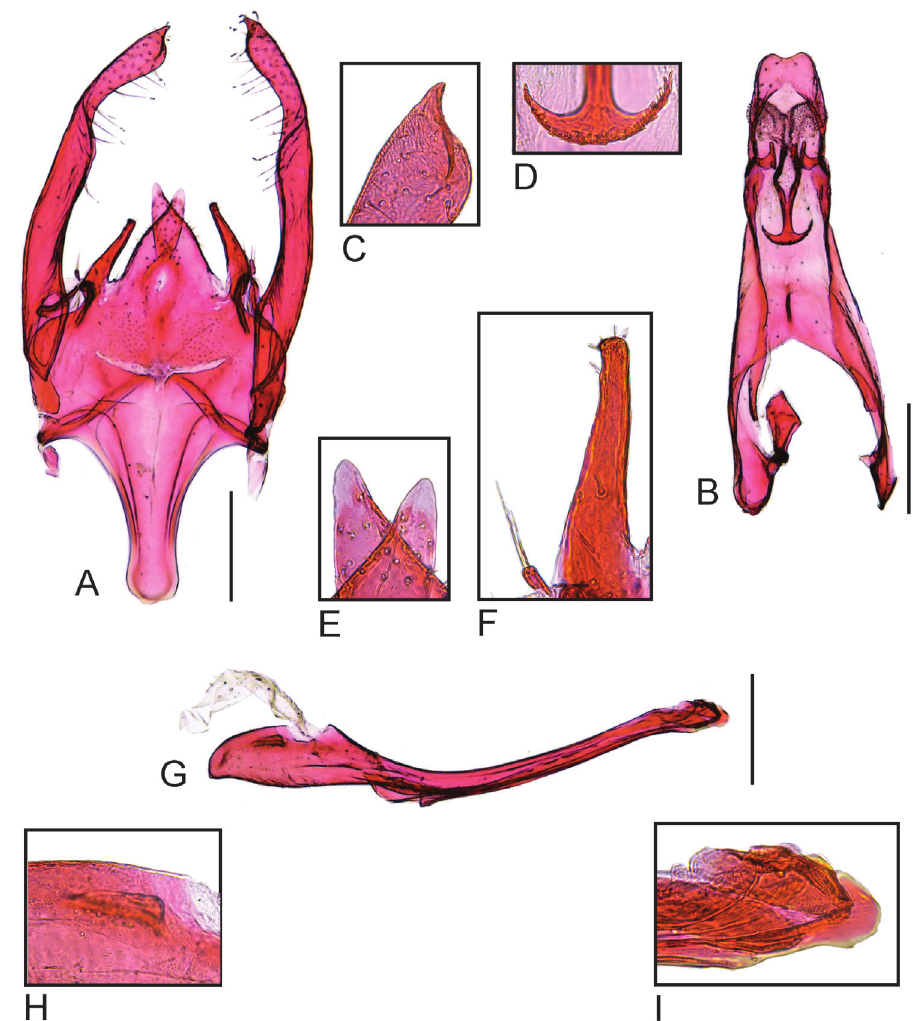
Figure 4. Male genitalia of Scrobipalpulopsis aguilaensis sp. nov. A valvae, vinculum and saccus, ventral B tegumen, uncus and gnathos, ventral C apex of left valva, ventral D distal part of gnathos showing finely serrated margin E tip of the left (right) and right (left) medial processes of the vinculum, ventral F left lateral process of the vinculum (right) and left sacculus (left), ventral G phallus, lateral H left lateral process of the coecum, lateral I tip of the phallus, lateral. Scale bar: 0.2